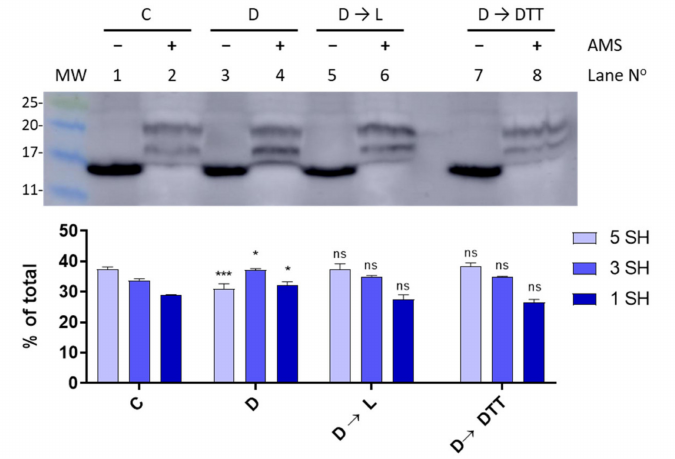
Figure 5. Light-dark modulation of FurA thiol oxidation. The in vivo redox status of FurA was assessed by Western blot under standard culture conditions of 30 µ Mol photons m − 2 s − 1 of white light (C), after 15 min of darkness (D), after 15 min of darkness followed by 3 h of exposure to 30 µ Mol photons m − 2 s − 1 of white light (D → L), and after 15 min of darkness followed by 3 h of exposure to 30 µ Mol photons m − 2 s − 1 of white light and 2 mM DTT (D → DTT). In all cases, Anabaena sp. PCC 7120 cultures were treated with 10% ( w / v ) trichloroacetic acid before being alkylated with 20mM AMS. The relative abundance of each band was quantified by scanning densitometry and represented data are mean ± standard deviation of two biological replicates and two technical replicates. Significance was measured using one-way analysis of variance (ANOVA) comparing with the control (C): ns non significant, * p < 0.05, *** p <